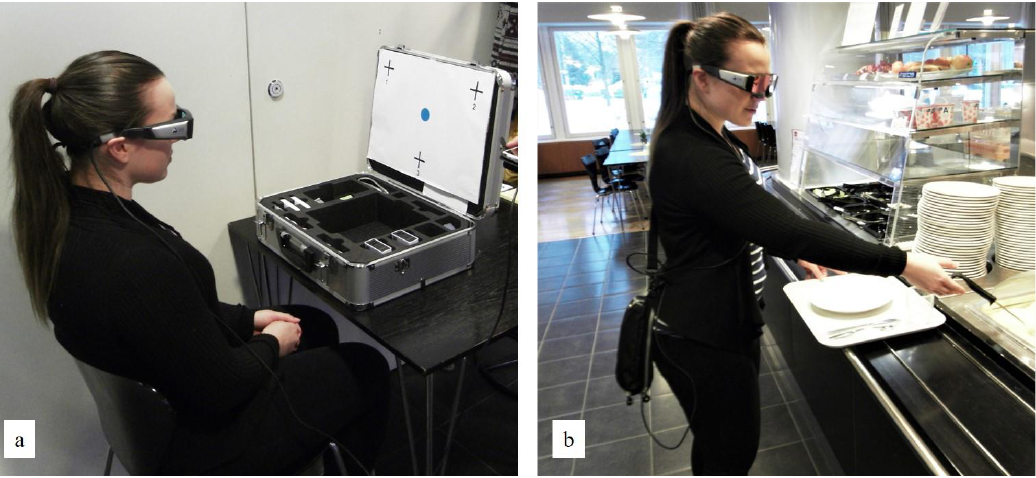
Figure 5. ( a ) The calibration of eye-tracking glasses; ( b ) Test subject wearing eye tracking glasses. Images reproduced with the permission of the study cafeteria and the test subject.